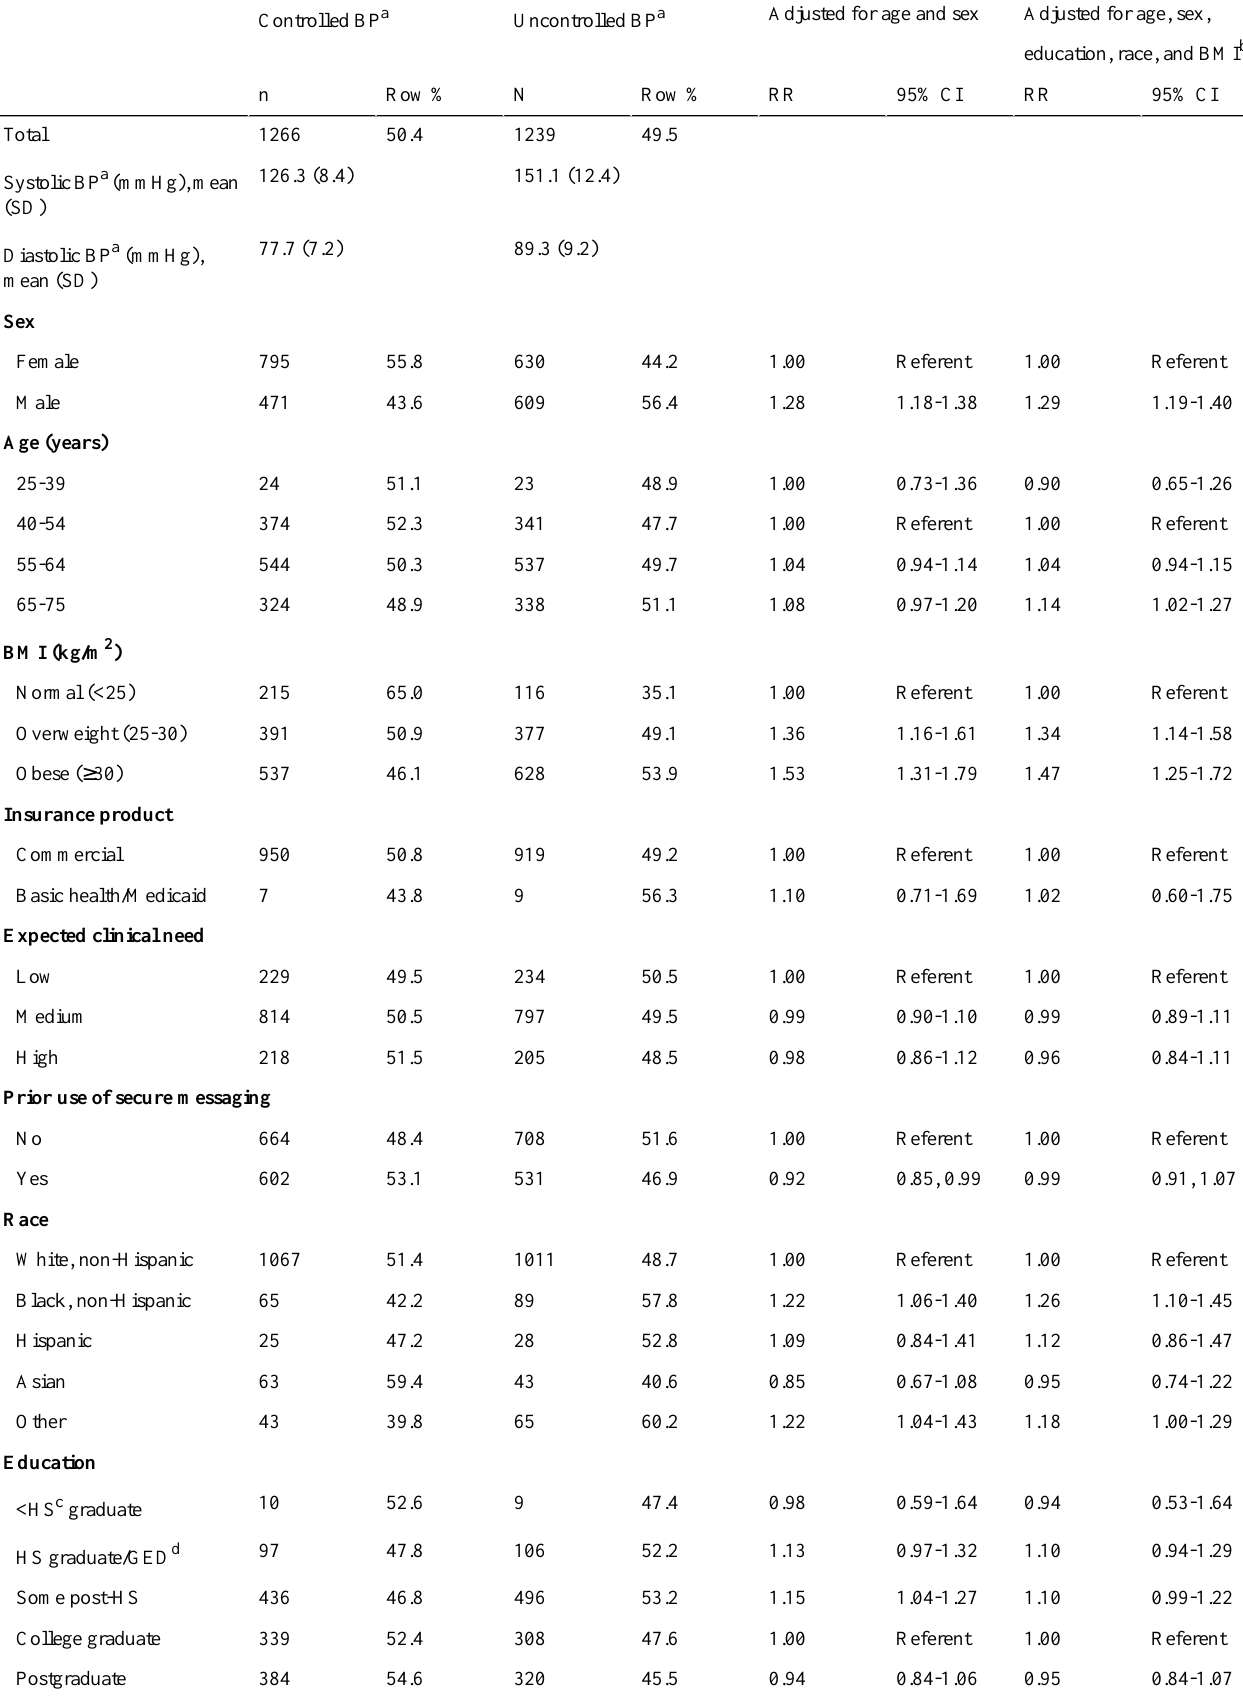
Table 3. Adjusted relative risk (RR) of uncontrolled blood pressure (BP) among patients completing the first screening visit (n = 2505)